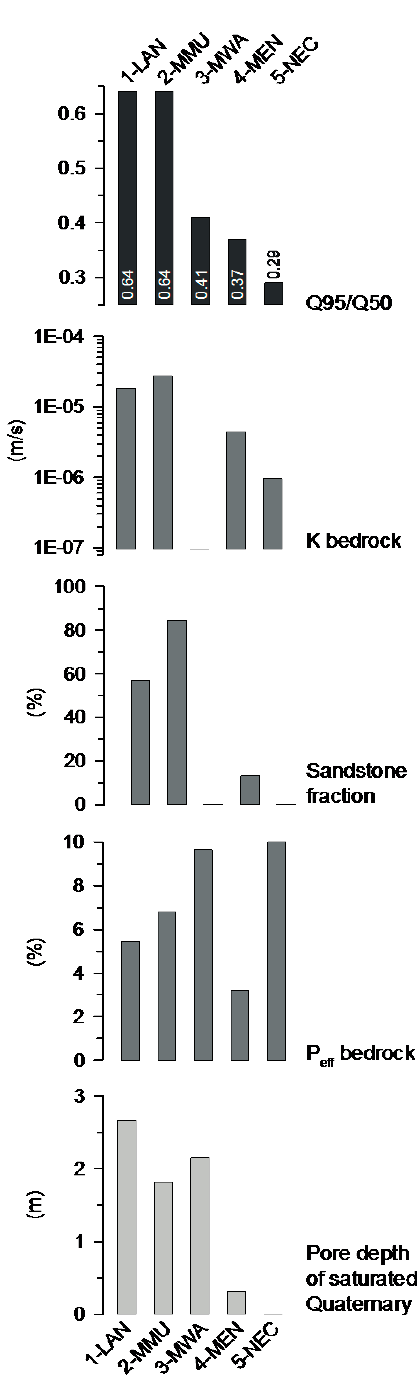
Figure 5. Numerical results of geological and hydrogeological analyses of the five selected catchments. The Q95 / Q50 index is compared to the found sedimentary and hydrogeological properties of the catchments. The low sensitivity to low flows of the 1-LAN and 2-MMU catchment is given by the high K of the bedrock due to the high fraction of sandstone bedrock and by the presence of productive alluvial aquifers (large pore depth of Quaternary). The 3-MWA with an intermediate Q95 / Q50 index benefits from the presence of productive alluvial aquifers (large pore depth of Quaternary). The catchments with a high sensitivity to low flows (low Q95 / Q50 index), 4-MEN and 5-NEC, do neither contain productive alluvial aquifers nor important volumes of sandstone bedrock. The P e ff of the bedrock does not reflect the sensitivity to low flows (Q95 / Q50 index).